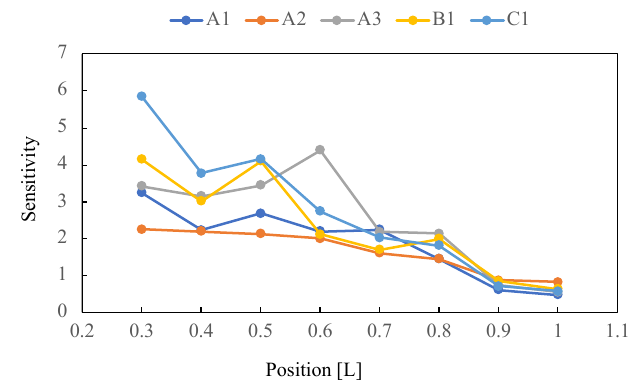
Figure 10. Sensitivity distribution of the participants. The pressure distribution at the seat cushion was measured by the pressure distribu- tion sensor (X-Sensor), and the skeletal coordinates of the femur were measured by the